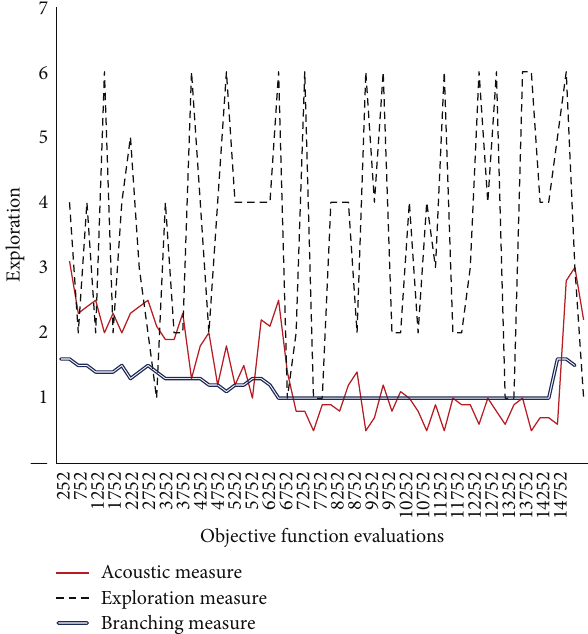
Figure 3: Evaluating ACO ustic against traditional indicators in ACO for the TSP instance d198 with nearest neighbourhood thresh- old = 𝜖 8.